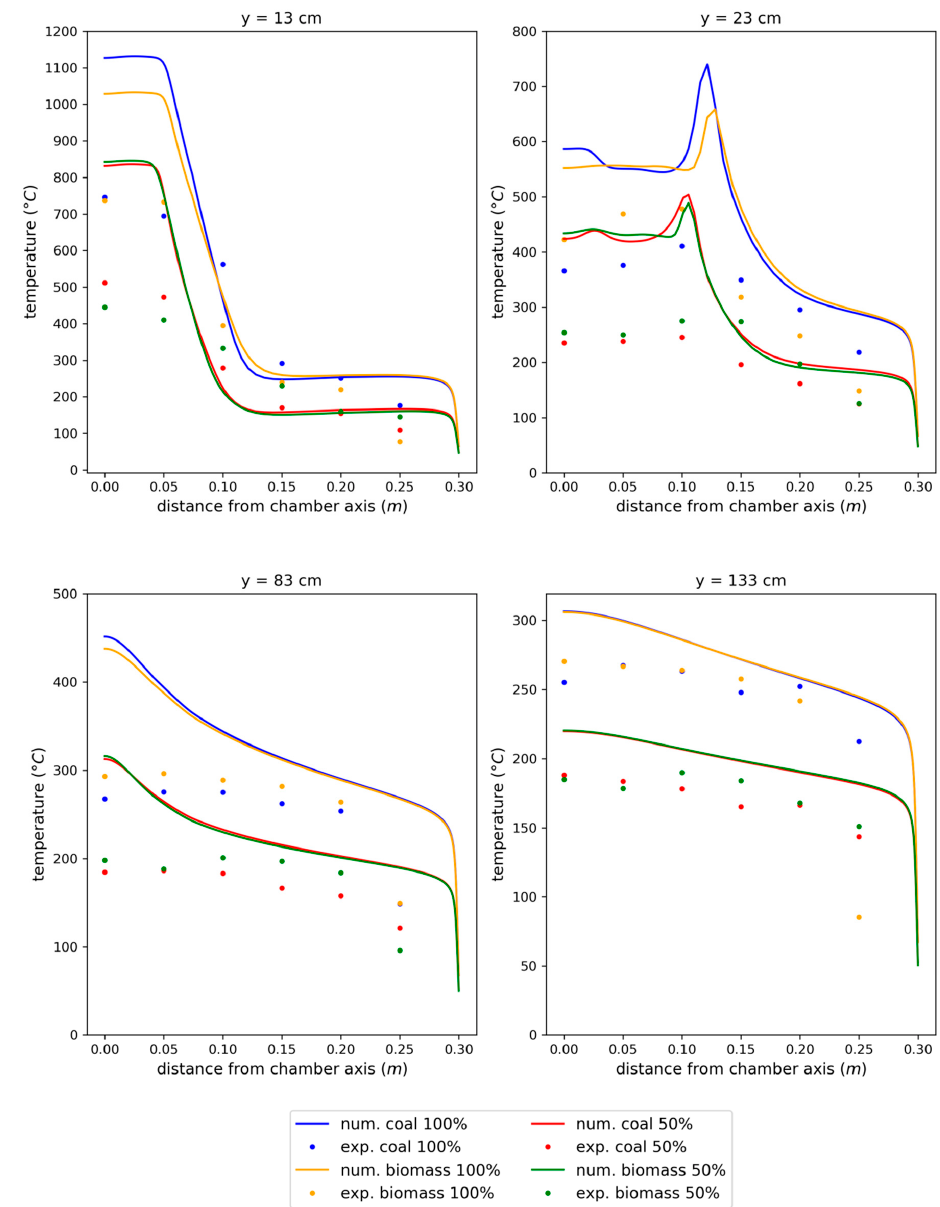
Figure 4. Comparison of an exhaust gas temperature distribution at different heights in the combustion chamber obtained from an experimental and a numerical part of the research.